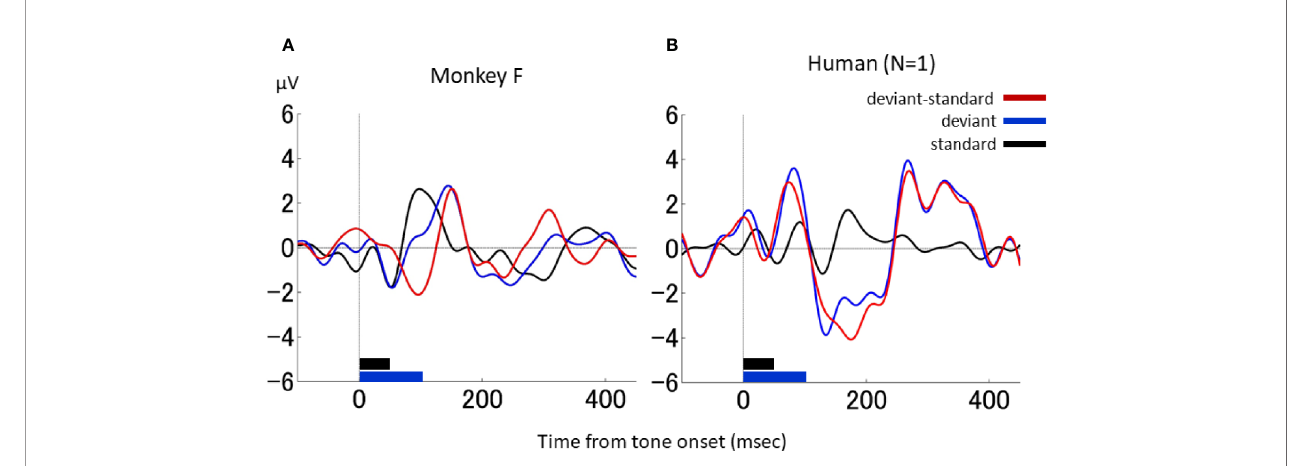
FIGURE 5 | dMMN in macaque monkeys and in a human. (A) , Waveforms in the duration-deviant experiment from one macaque monkey (monkey F). (B) , Waveforms in the duration-deviant experiment from one human. Conventions are the same as in